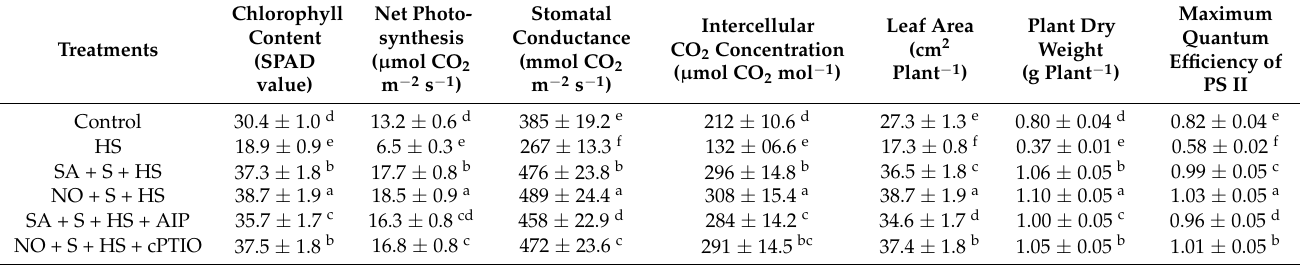
Table 3. Chlorophyll content (SPAD value), net photosynthesis, stomatal conductance, intercellular CO 2 concentration, leaf area, plant dry weight and maximum quantum efficiency of pigment system (PS) II in wheat ( Triticum aestivum L.) cv. HD-3226 treated with 0.5 mM salicylic acid (SA) or 50.0 µ M nitric oxide (NO) together with 2.0 mM SO 4 − 2 and/or 0.5 mM AIP and/or 100 µ M cPTIO in presence